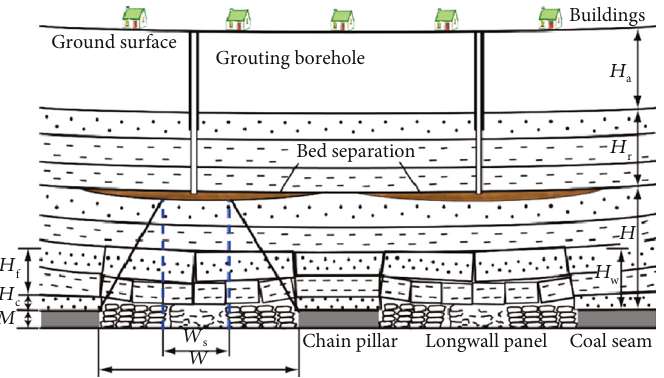
Figure 1: Principle of isolated overburden grout injection [21].